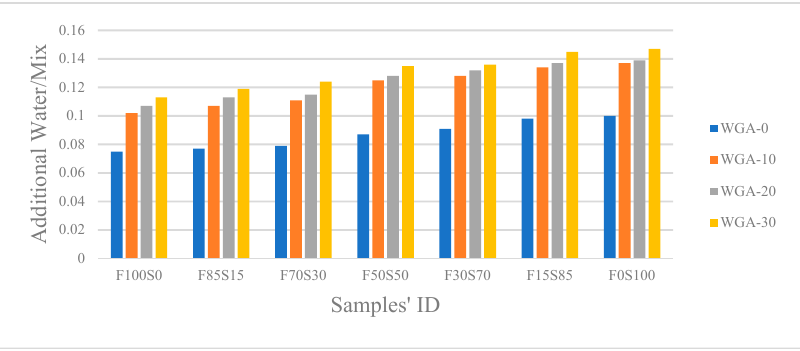
Figure 3. Additional water for paste mixes